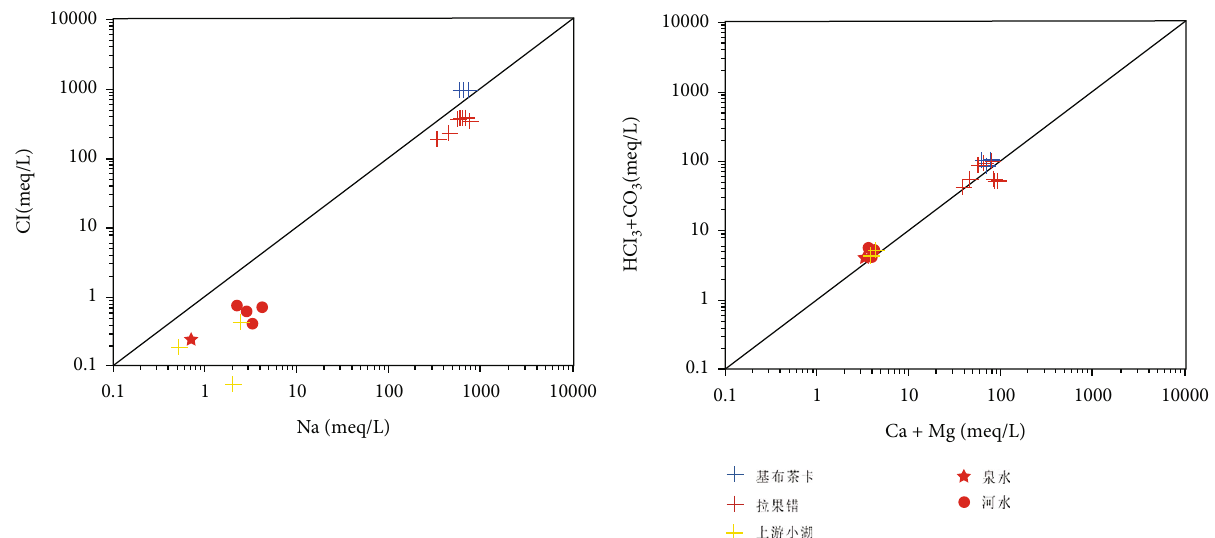
Figure 5: Molar ratio of Na/Cl and (Ca 2+ + Mg 2+ )/(HCO 3- + CO 3- ) in water of the Lakkor Co